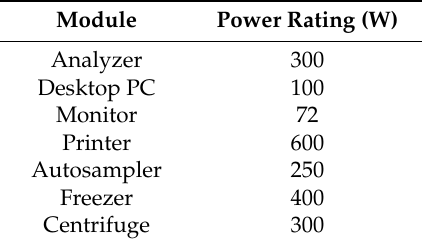
Table 2. Power ratings of the modules in Biochrom 30+ amino acid analyzer physiological